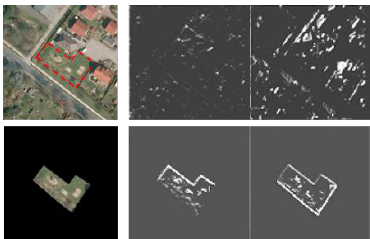
Figure 3: Feature maps from the first convolutional layer for a land use object (right) and corresponding image patch (left). Top / bottom: without / with setting the grey values outside the object to zero.